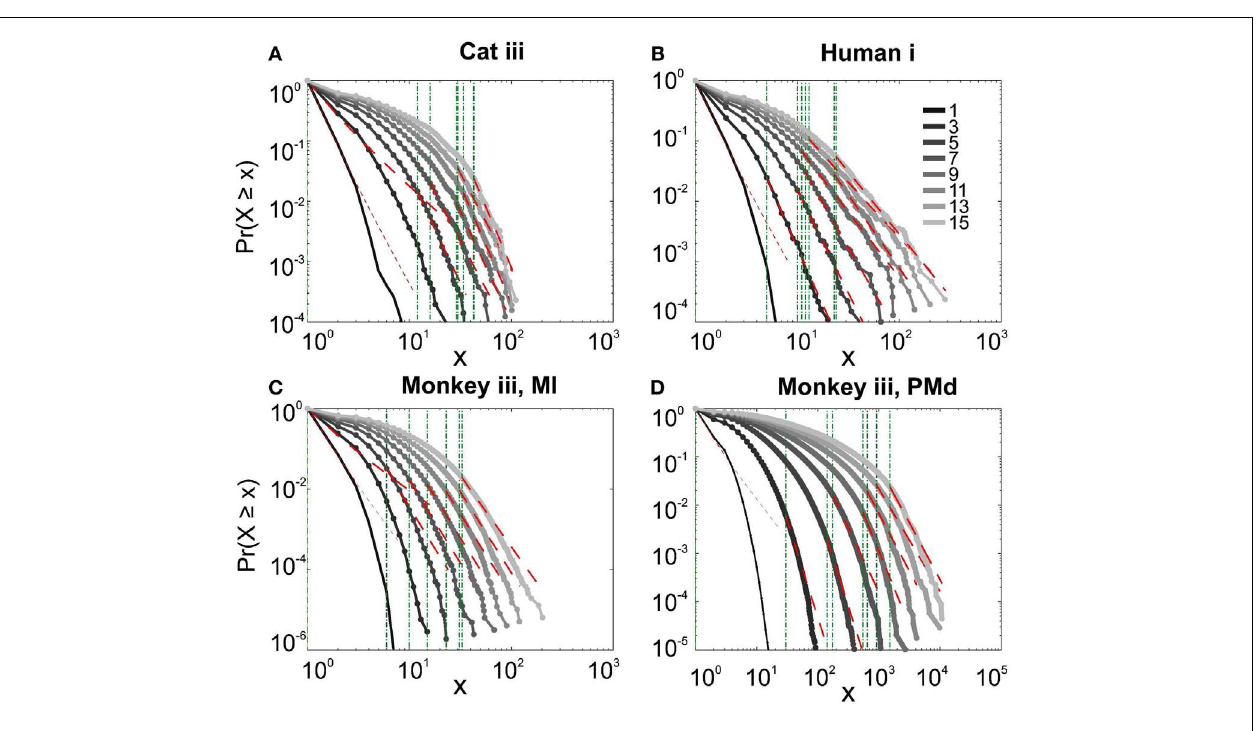
criticality, the curves follow different partial power-law with high exponents and variable lower bound values.The avalanche dynamics do not show a state-dependent trend. For the mean/STD exponent values, see Table 1